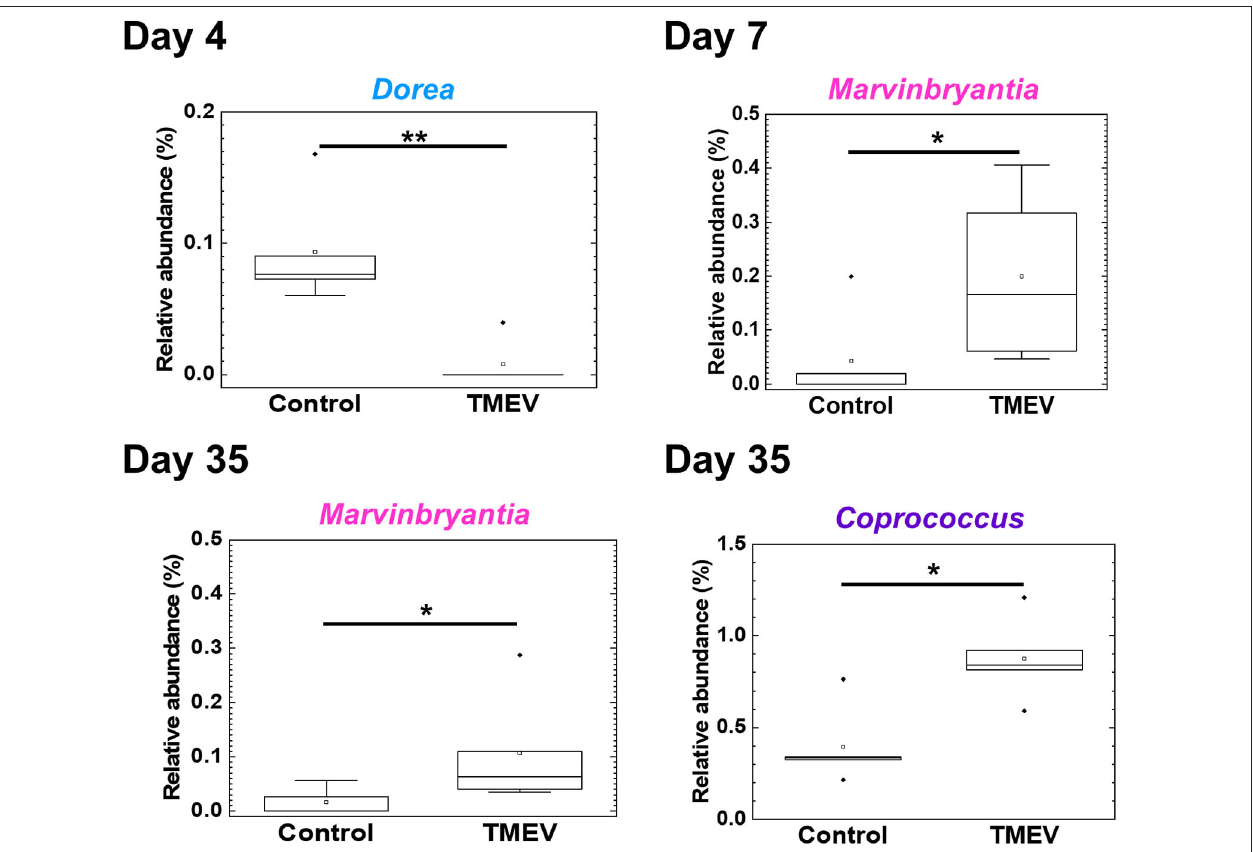
FIGURE 5 | Three bacterial genera changed their relative abundance in the TMEV-infected group, compared with controls. Following the TMEV infection, the genus Dorea was decreased on day 4 (** P < 0.01) and the genus Marvinbryantia was increased on days 7 and 35 (* P < 0.05). The genus Coprococcus was increased on day 35 (* P < 0.05). We compared relative abundance of fecal microbes at the genus level using five fecal samples per group between TMEV-infected and control groups and determined the statistical differences using Student’s t